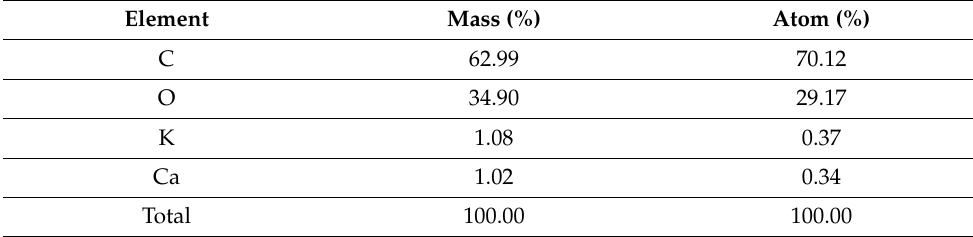
Table 2. The surface element analysis of AC-RGL adsorbent.